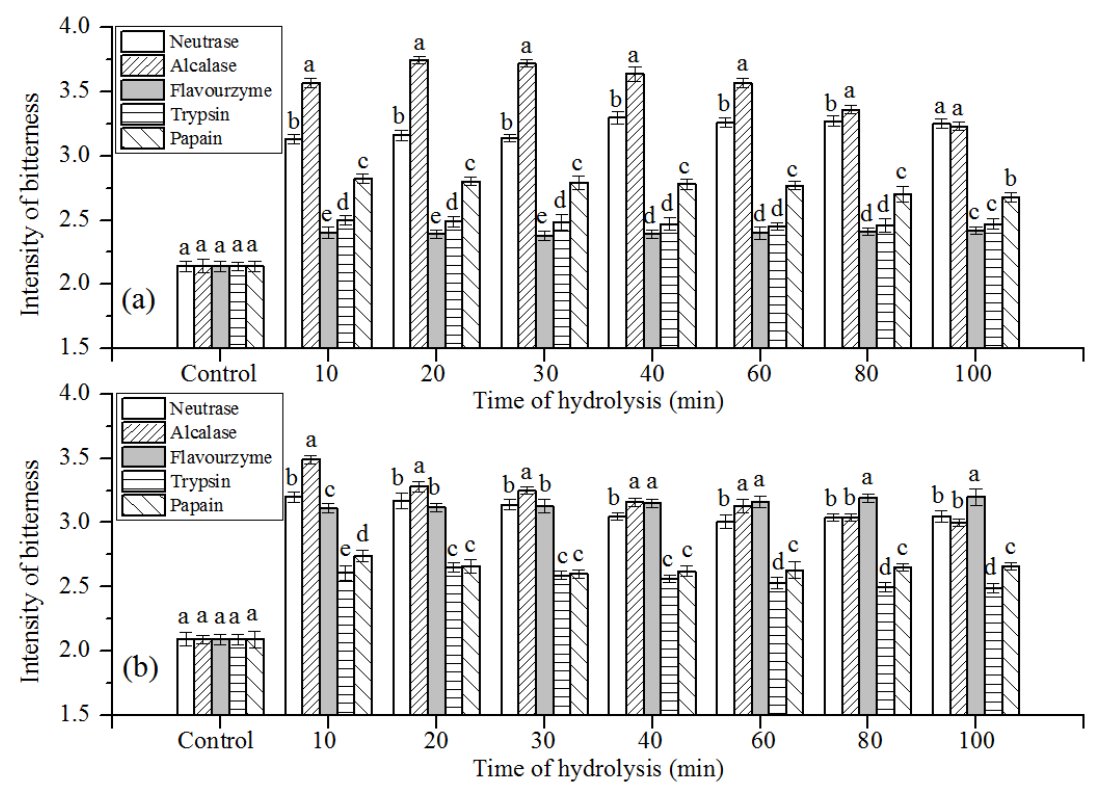
Figure 3. ( a ) Effect of hydrolysis on the bitterness intensity of CGMHs using different proteases in combination with Protamex; ( b ) Effects of hydrolysis on the bitterness intensity of CGMHs using different proteases in combination with pancreatin. Significant differences between results are indicated by different letters ( p <